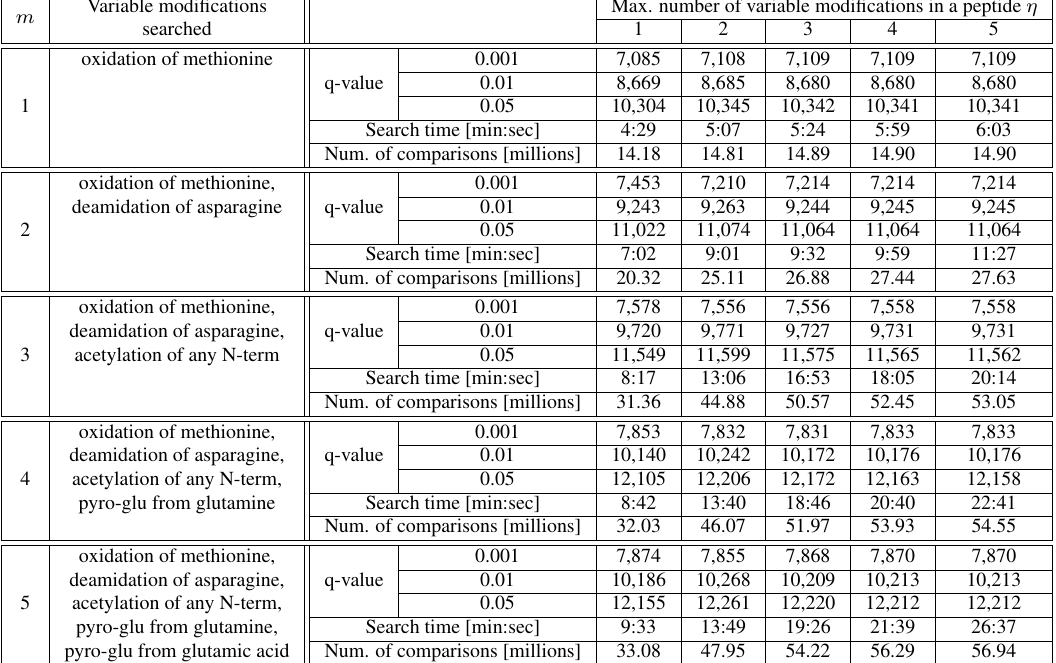
Table 4: Numbers of identified peptides, search times and total numbers of comparisons of Hum48 with spectra generated from human protein sequences from Swiss-Prot for increasing number of searched variable modifications m 2 ⟨ 1 ; 5 ⟩ and for increasing maximum number of variable modifications in a peptide (cid:17) 2 ⟨ 1 ; 5 ⟩